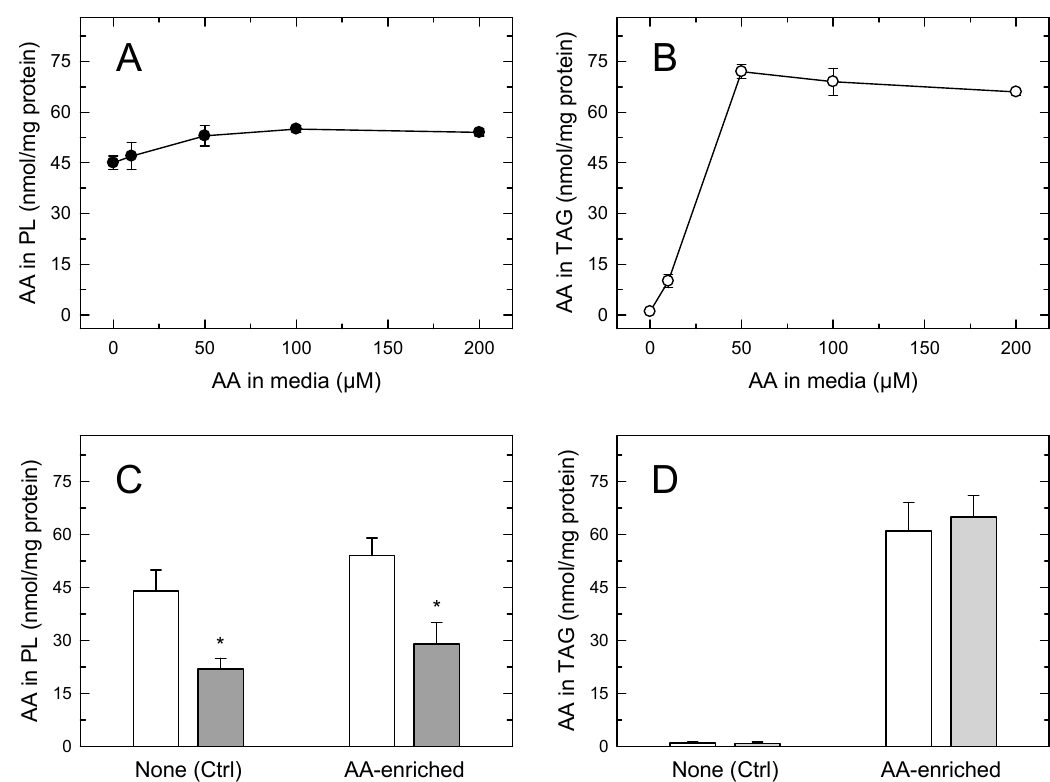
Figure 5. The AA content of human monocytes incubated in AA-rich media ( A , B ). The cells were incubated with the indicated concentration of AA for 24 h. The fatty acid was added to the media complexed with bovine serum albumin at a 2:1 ratio. After the incubations, the AA content of cellular phospholipids ( A ) or TAG ( B ) was analyzed by GC/MS. Comparison of the AA mobilization responses between normal circulating cells and AA-enriched cells ( C , D ); the cells were either untreated (open) bars) or treated with 1 mg/mL opsonized zymosan for 2 h (grey bars). The AA content in phospholipids ( C ) or TAG ( D ) was analyzed by GC/MS. Data are expressed as means ± SEM of three independent determinations. * p < 0.05, significantly different from unstimulated cells.